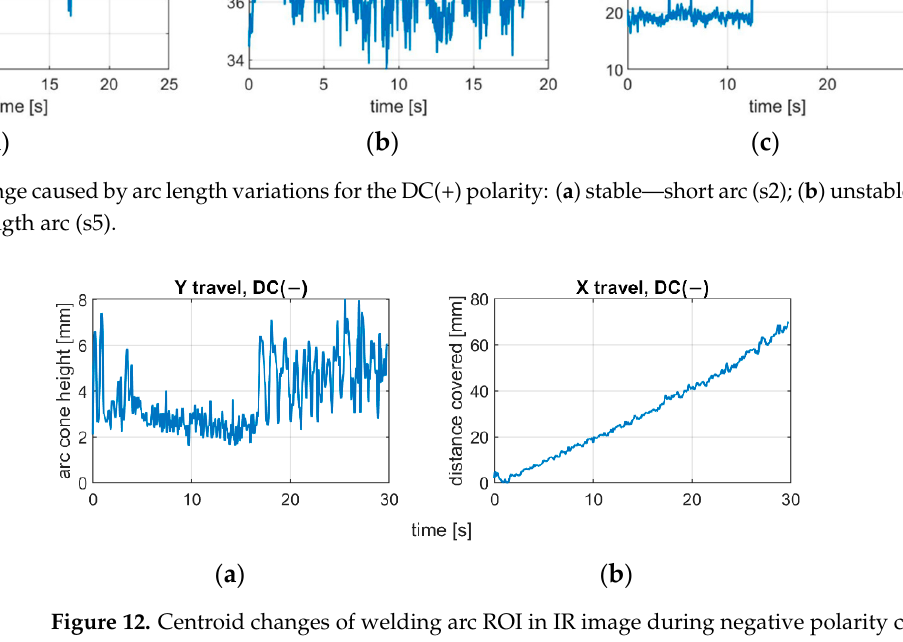
with varying arc length (s12): ( a ) welding arc length estimate; ( b ) welding speed estimate.